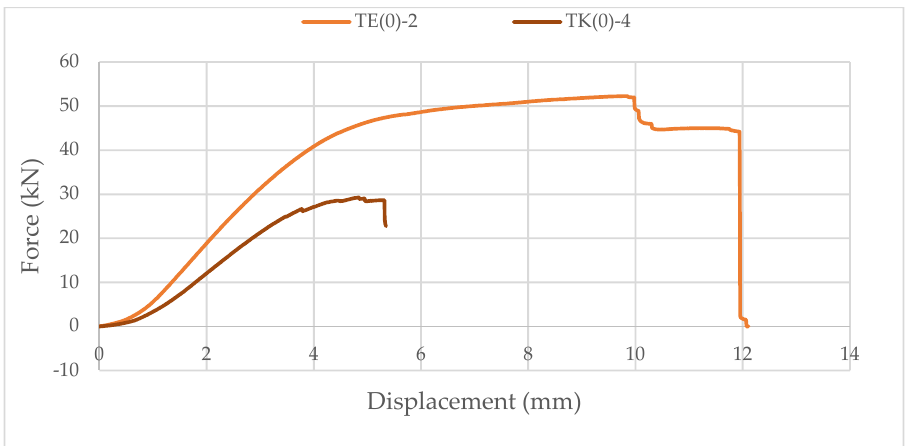
Figure 21. Comparison of the force-displacement curve for compression perpendicular to the grain of samples with elliptical and circular cavities in the direction of the weaker axis.